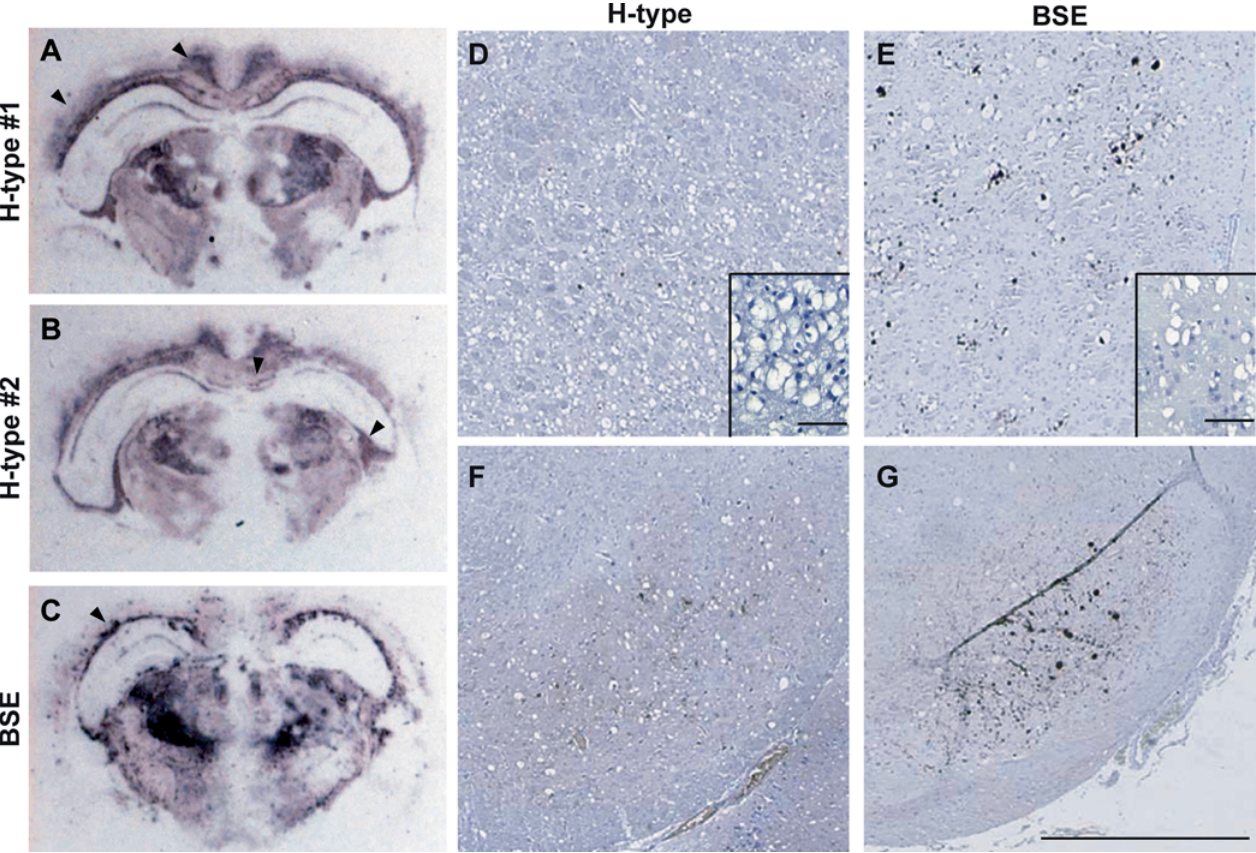
Figure 3. Regional Distribution of PrP res and Vacuolar Changes in the Brains of Bovine Transgenic Mice Infected with H-Type or BSE Agents Histoblots of representative coronal sections of tgBov mouse brains at the levels of the hippocampus are shown. The distribution of PrP res deposits was similar among H-type isolates (A) (B), and different from that of cattle BSE (C) in several areas indicated by arrowheads, such as the cortex, the corpus callosum and dorsal commissure, alveus, fimbria, and stratum oriens of the hippocampus. Note that intensity of PrP deposition markedly differed between H-type and BSE agents. Illustration of how this appears by immunohistochemistry in the striatum (D) (E) and substantia nigra (F) (G), H-type– infected mice being less intensively labelled than those infected with BSE agent. By contrast, spongiosis was much more severe in H-type–infected brains. Bars: 30 l m; insert: 7 l m. DOI: